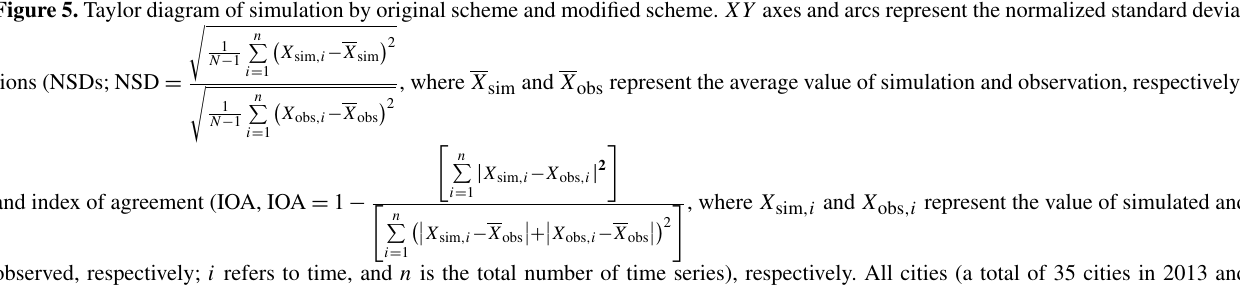
, where X sim ,i and X obs ,i represent the value of simulated and observed, respectively; i refers to time, and n is the total number of time series), respectively. All cities (a total of 35 cities in 2013 and 78 cities in 2014, 2015 and 2017) are shown by dots, and black (red) represents the original (new) scheme. The root mean square (rms) is denoted by the dashed blue line, and the arrow indicates the change of the new scheme compared to the original scheme at the same station.